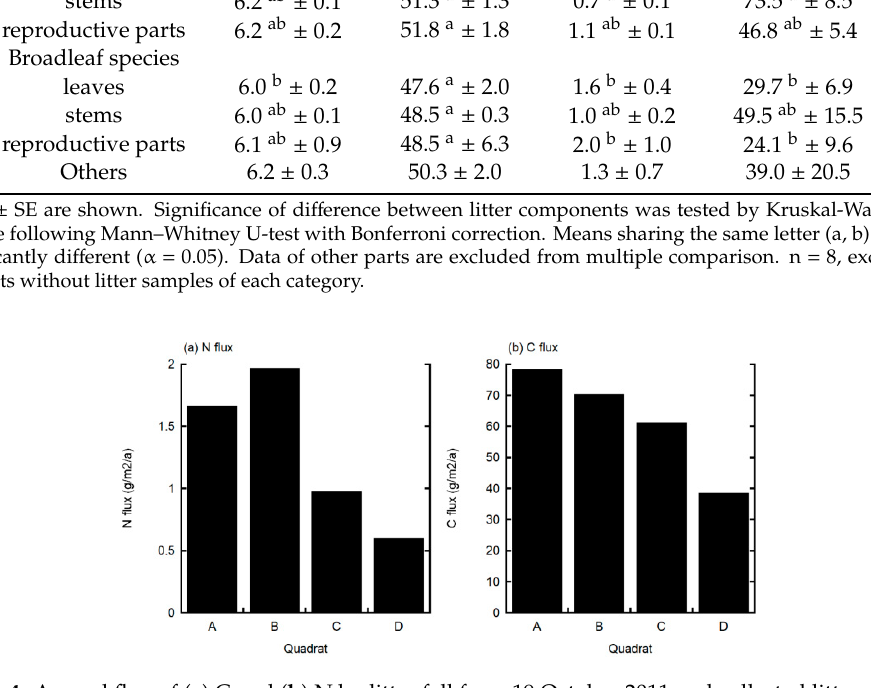
Figure 4. Annual flux of ( a ) C and ( b ) N by litter fall from 19 October 2011 and collected litters until 1 November 2012 in Sanri-Matsubara Forest, south-western Japan.